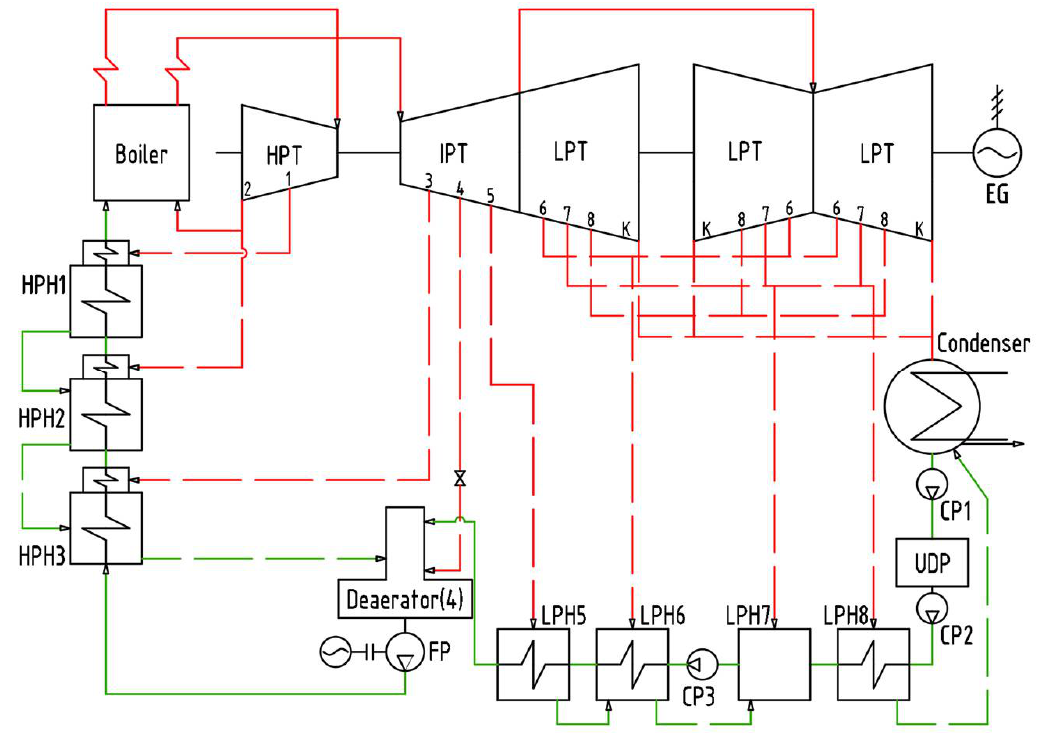
Figure 1. The base 300 MW power unit heat flow diagram.